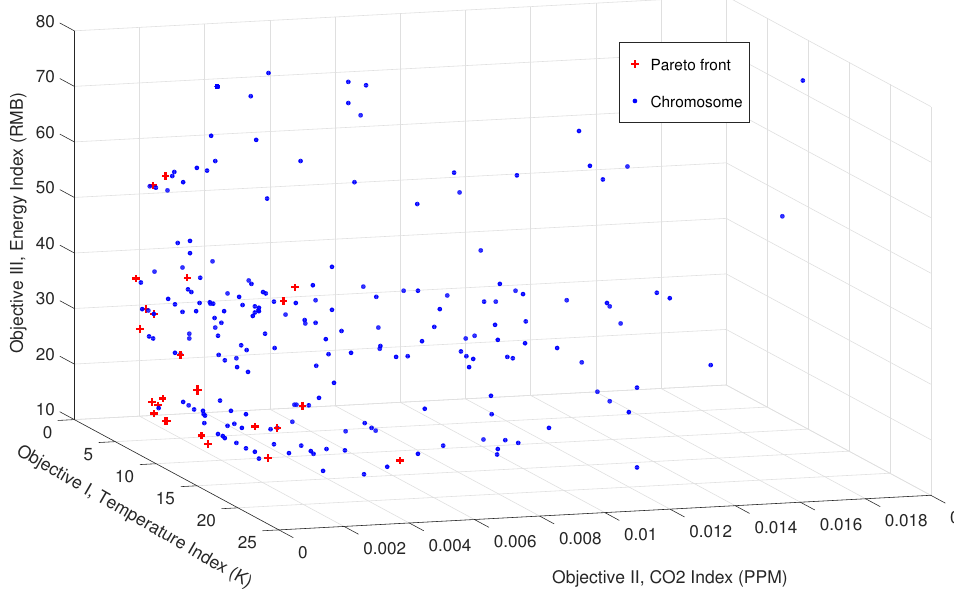
Figure 10. Tri-dimensional projection of the multiple objectives represented by